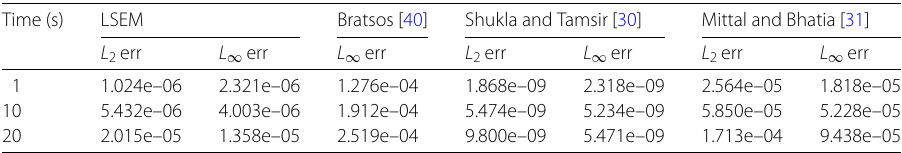
Table 4 Comparison of the L 2 err and L ∞ err of Example 5.3 with N = 7, N e = 30, and k = 0.001 at different time levels